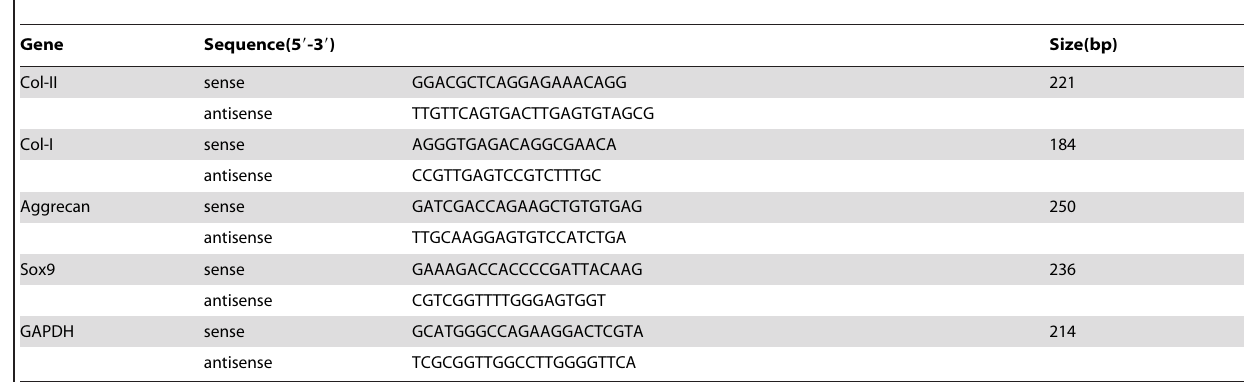
Table 1. Real-time PCR primers and product